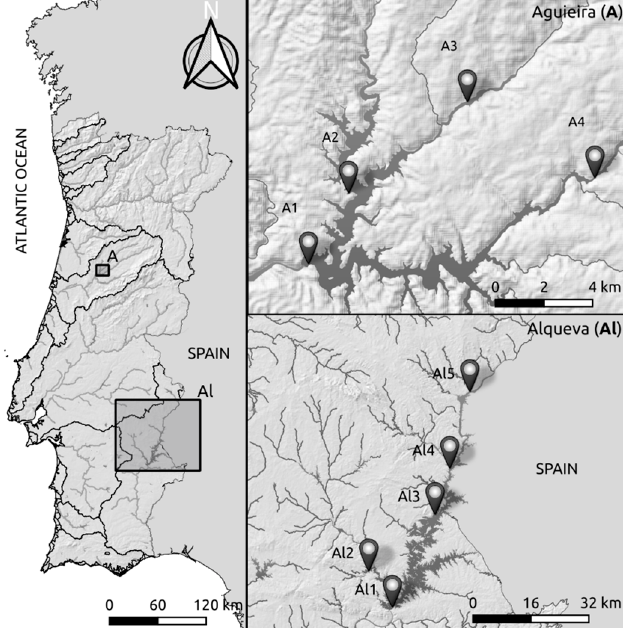
Figure 1. Reservoirs’ locations within Portugal. Aguieira (A) reservoir sampling sites: A1 (40 ◦ 0 (cid:48) 7.942 (cid:48)(cid:48)